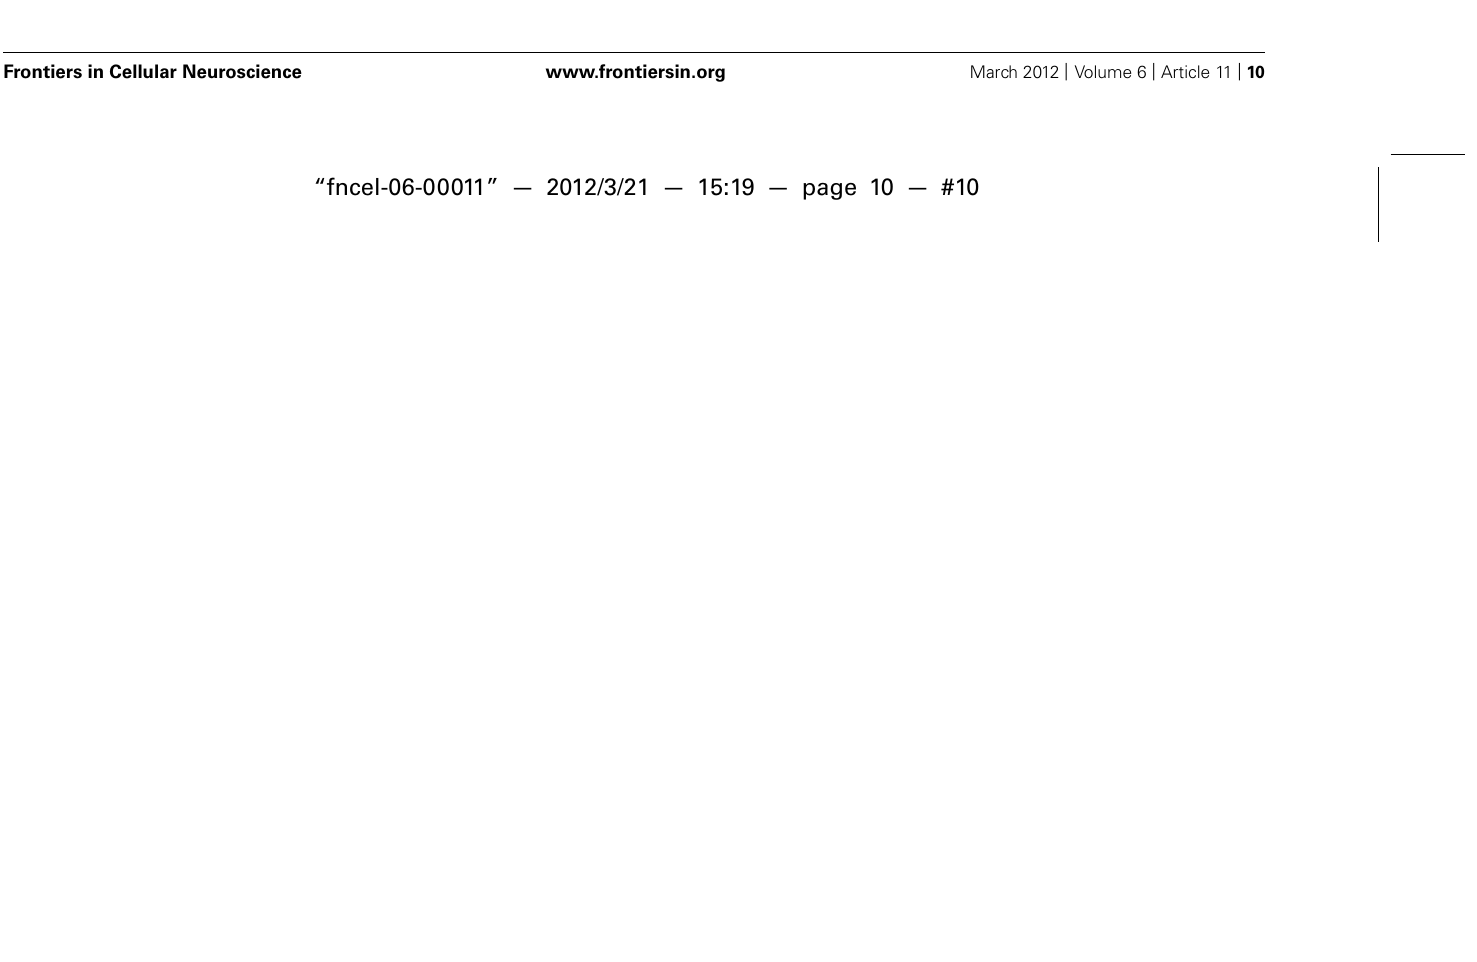
FIGURE 7 | Darkfield images of immunohistochemistry for GFP 10 weeks after grafting of neural cell preparations generated from human ES cells. These panels are enlarged versions of the boxed areas depicted in Figure 6 and show GFP + fibers: (A) extending from the graft core (*) into the surrounding striatum and ventrally into the ventral palladium; (B) coursing through forceps minor and into the adjacent secondary motor, cingulate, and pre-limbic cortices; (C) extending through the cingulum into the overlying cingulate cortex; (D) extending through the corpus callosum of the contralateral hemisphere; (E) running caudally through the entopeduncular nucleus and branching medially into the adjacent zona incerta and nearby thalamic nuclei; (F) at the level of the midbrain, predominately associated with white matter tracts in the